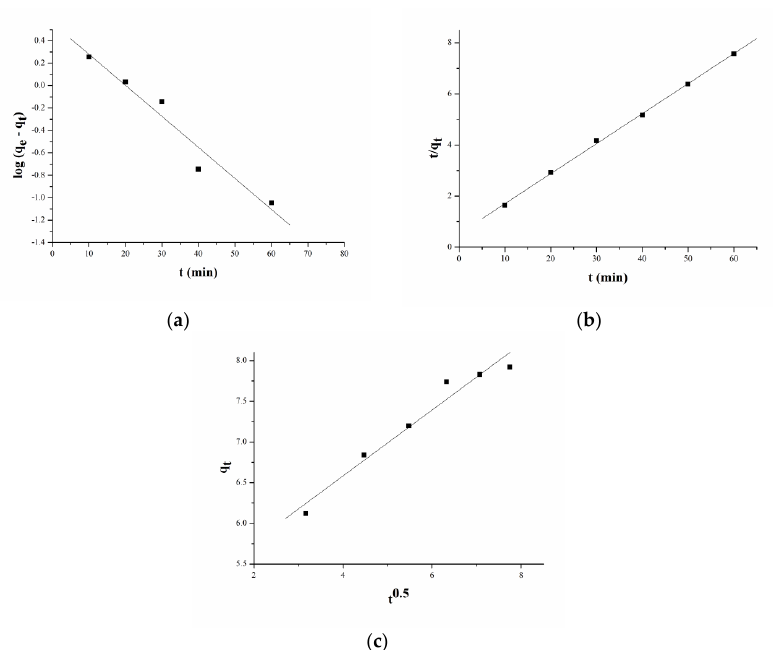
Figure 9. Plots for ( a ) pseudo-first-order, ( b ) pseudo-second-order, and ( c ) intra-particle diffusion models for adsorption of phenol on GO–cellulose composite . Table 6. Parameters for kinetic and intra-particle diffusion models .